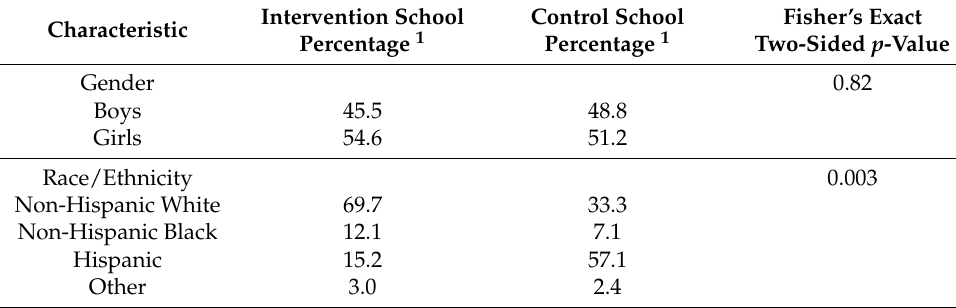
Table 1. Gender and race/ethnic characteristics of the intervention ( n = 33) and control ( n = 42) schools, 2017–2018 school year. Intervention School Control School Characteristic Percentage 1 Percentage